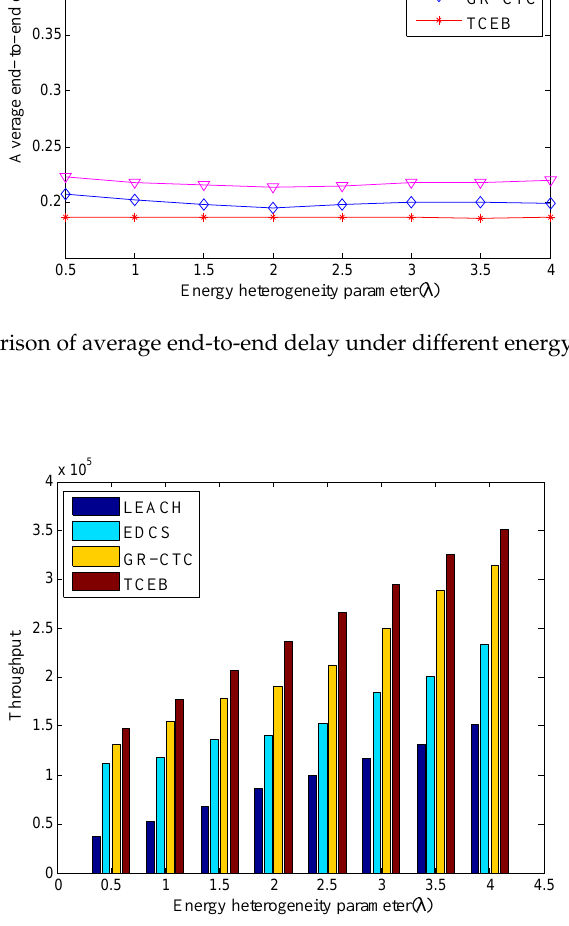
Figure 13. The comparison of throughput under different energy heterogeneity factor ( n = 100 ) .